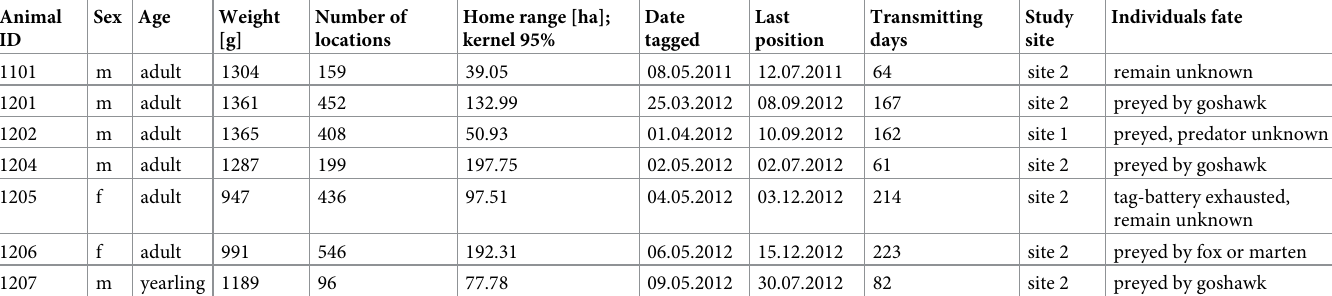
Table 1. Summary of tagged black grouse individuals including number of GPS locations, date of capture and duration of data collection. Animal